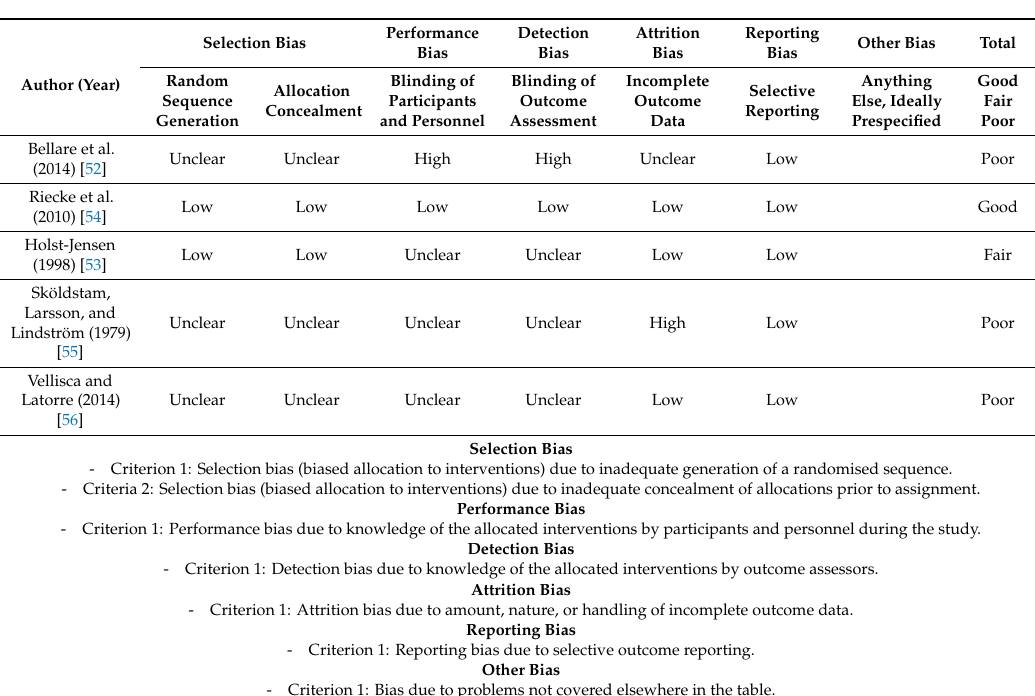
Table 2. Risk of bias assessment of randomised controlled trials ( n =